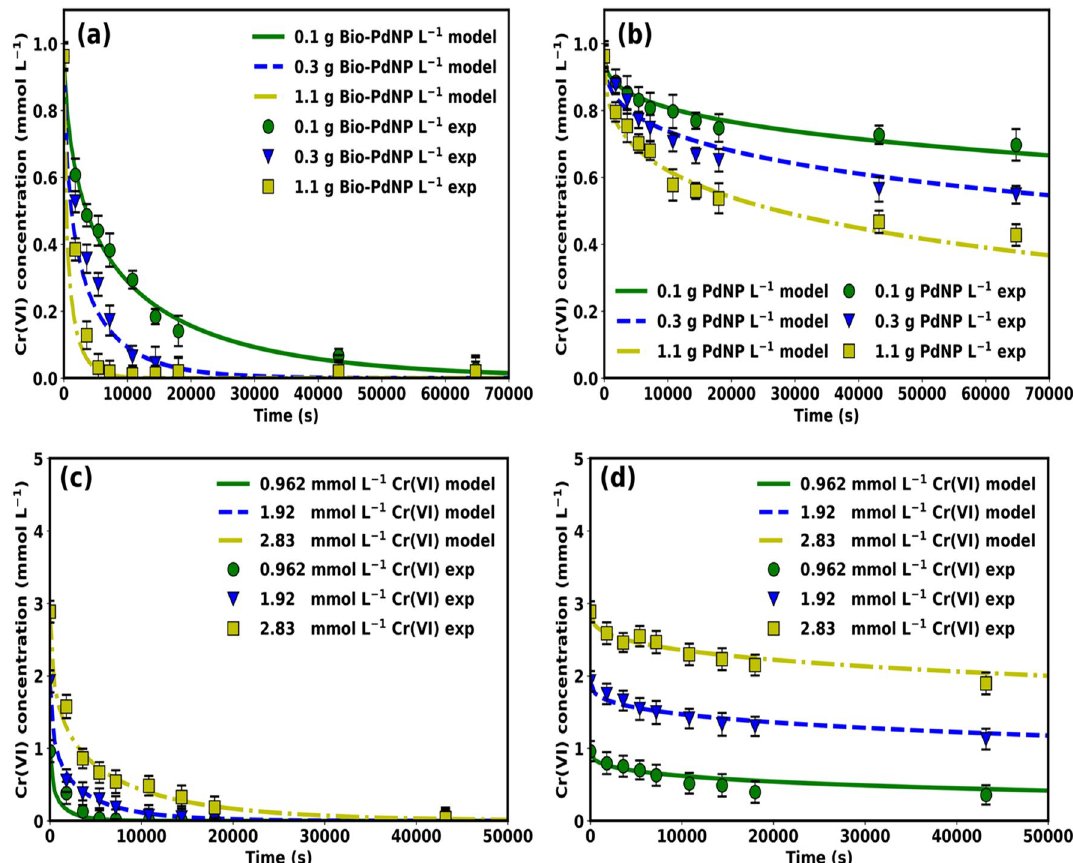
Figure 9. Model validation with experimental data at varying ( a ) catalyst concentration of Bio-PdNP at 0.962 mmol L −1 Cr(VI), ( b ) catalyst concentration of Chem-PdNP (represented as PdNP on the figure) at 0.962 mmol L −1 Cr(VI), ( c ) initial Cr(VI) concentration using 1.1 g Bio-PdNP L −1 , ( d ) initial Cr(VI) concentration using 1.1 g Chem-PdNP L −1